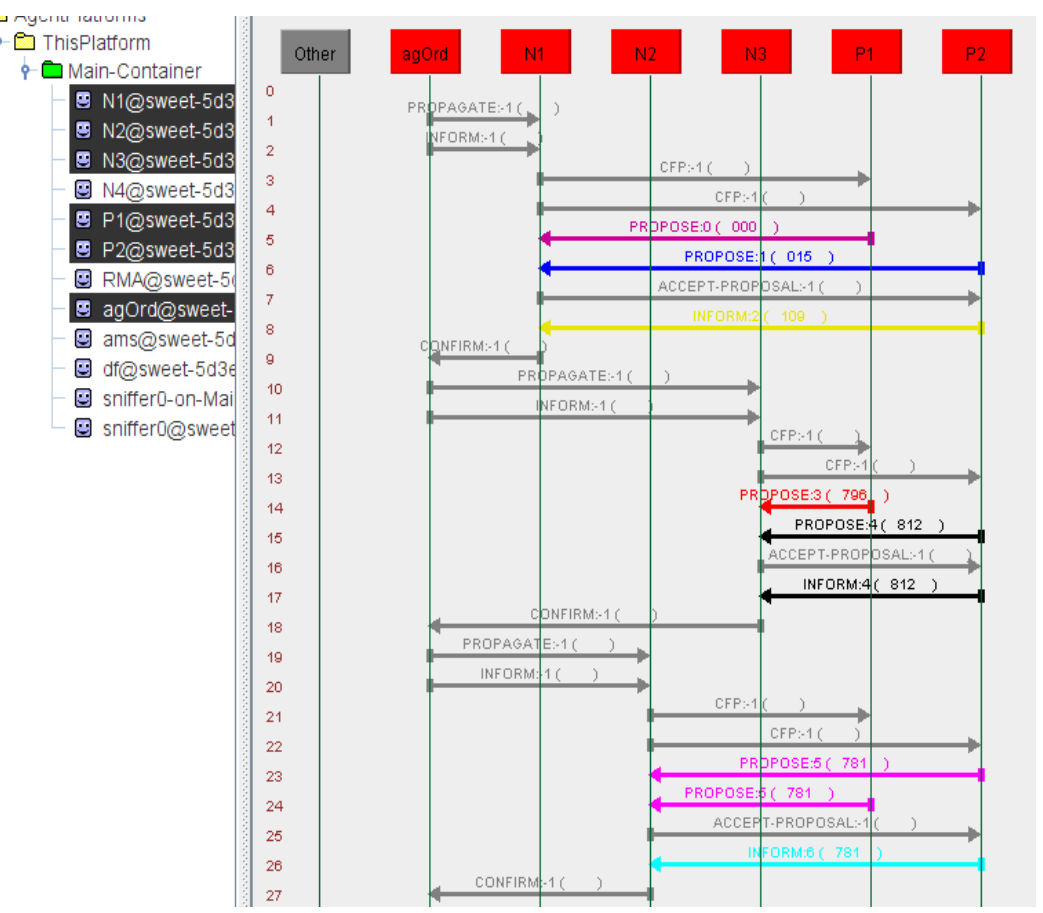
Figure 11. Messages exchanged between the agents of the proposed multi-agent system.